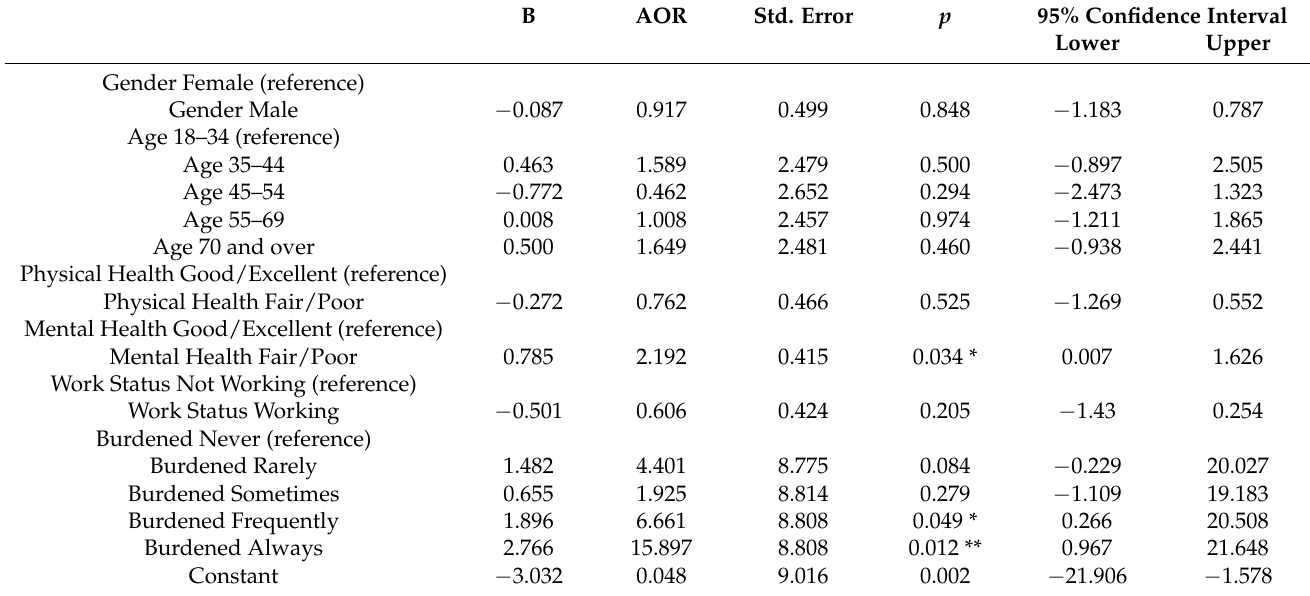
Table 3. Predisposing variable predictors of moving to severe loneliness ( n = 293).